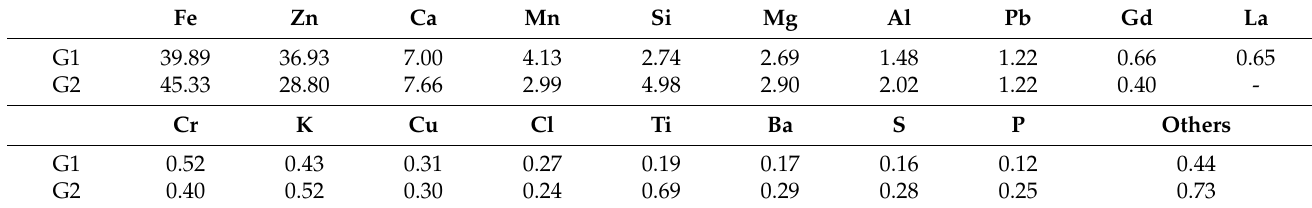
Table 2. Composition of the EAFD powders from X-ray fluorescence